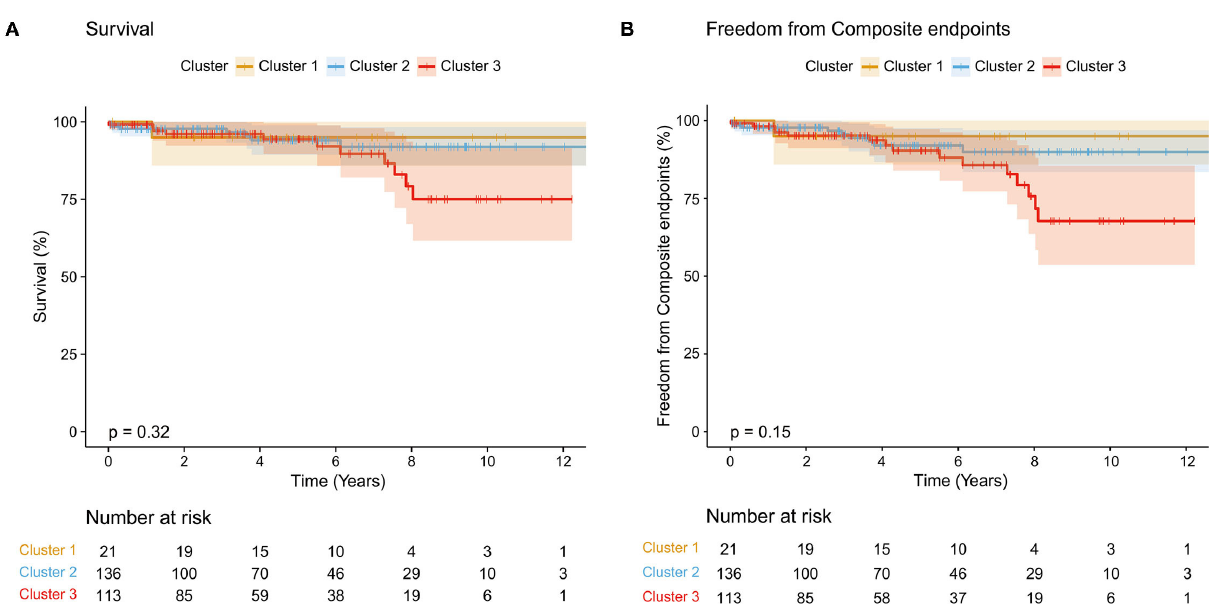
FIGURE 3 | Kaplan-Meier analysis of three clusters. (A) Comparison of survival rate among three clusters ( p = 0.32); (B) Freedom from composite endpoints among three clusters ( p = 0.15). Shading indicates a 95%